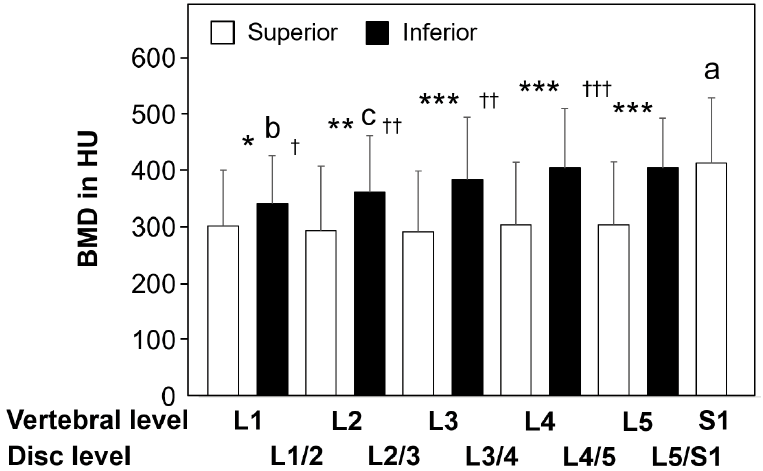
Fig 5. Comparison of the endplate BMD among different spinal levels and between the superior and inferior endplates within the same vertebra or same intervertebral disc. a: p < 0.0001 compared with superior endplates at L1, L2, L3 and L4. p < 0.0005 compared with superior endplates at L5. compared with inferior endplate at L1 (p < 0.0007) and L2 (p < 0.05). b: compared with inferior endplates at L3 (p < 0.009), L4 (p < 0.005) and L5 (p < 0.003). c: p < 0.03 compared with inferior endplate at L3. � : p < 0.008 between superior vs. inferior endplates in the same vertebra. �� : p < 0.0005 between superior vs. inferior endplates in the same vertebra. ��� : p < 0.0001 between superior vs. inferior endplates in the same vertebra. †: p < 0.0004 between superior vs. inferior endplates in the same disc. ††: p < 0.0001 between superior vs. inferior endplates in the same disc. †††: p < 0.0002 between superior vs. inferior endplates in the same